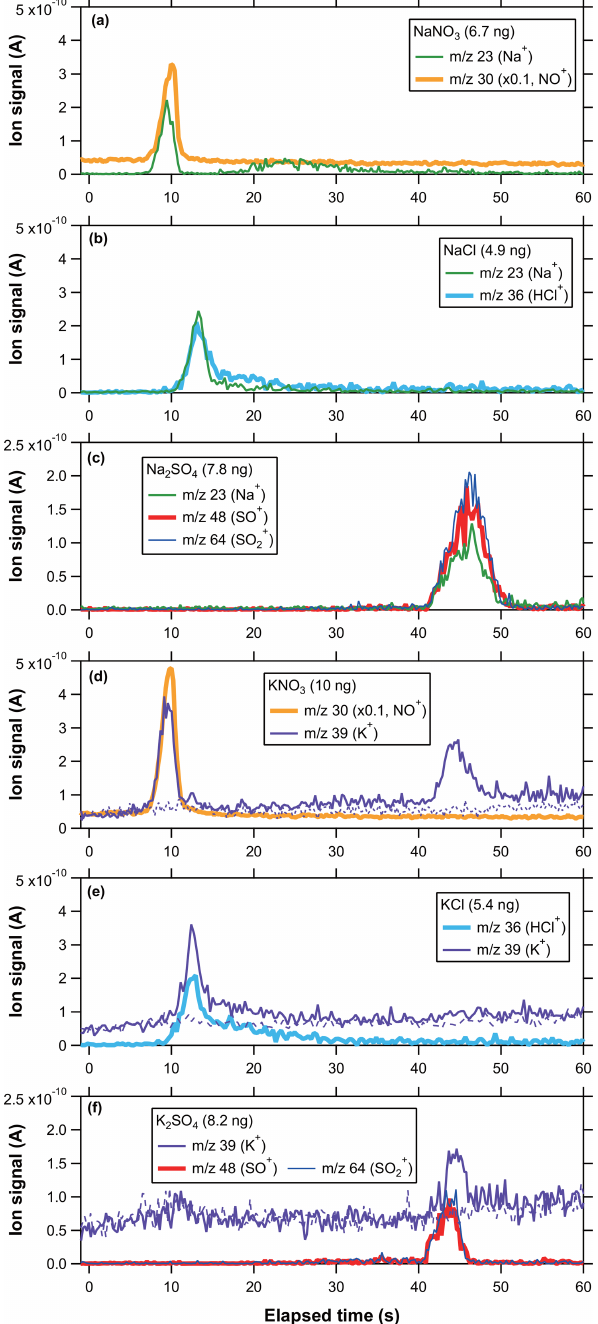
Figure 2. Temporal profiles of ion signals originating from single- component (a) SN, (b) SC, (c) SS, (d) PN, (e) PC, and (f) PS par- ticles as a function of elapsed time since turning the laser on. The ion signals at m/z 30 were scaled by a factor of 0.1 for clarity of the presentation. Zero air signals at m/z 39 are also plotted in (d) – (f) . Zero signals at m/z 23, 30, 36, 48, and 64 are not displayed because the signal levels were comparable to the baselines (i.e., ion signals before the laser irradiation). Particle mass loadings (in ng) are shown in the legend. The elapsed time may contain an error of ∼ 1s because the laser operation was performed